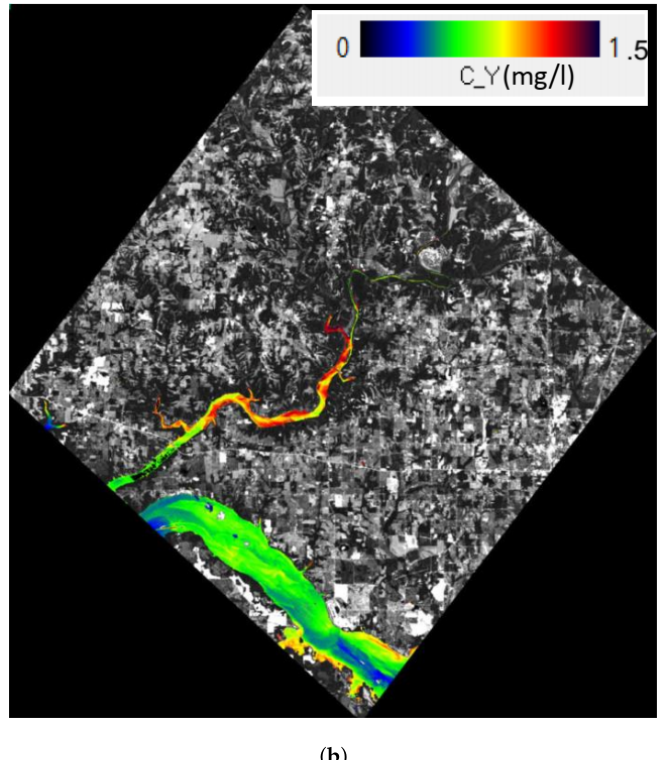
Figure 14. DESIS First Images. ( a ) RGB composition of the first image from Tyler, Texas, U.S., taken on 31 August 2018. ( b ) Colored dissolved organic matter (CDOM) in Huntsville, Alabama, U.S.,